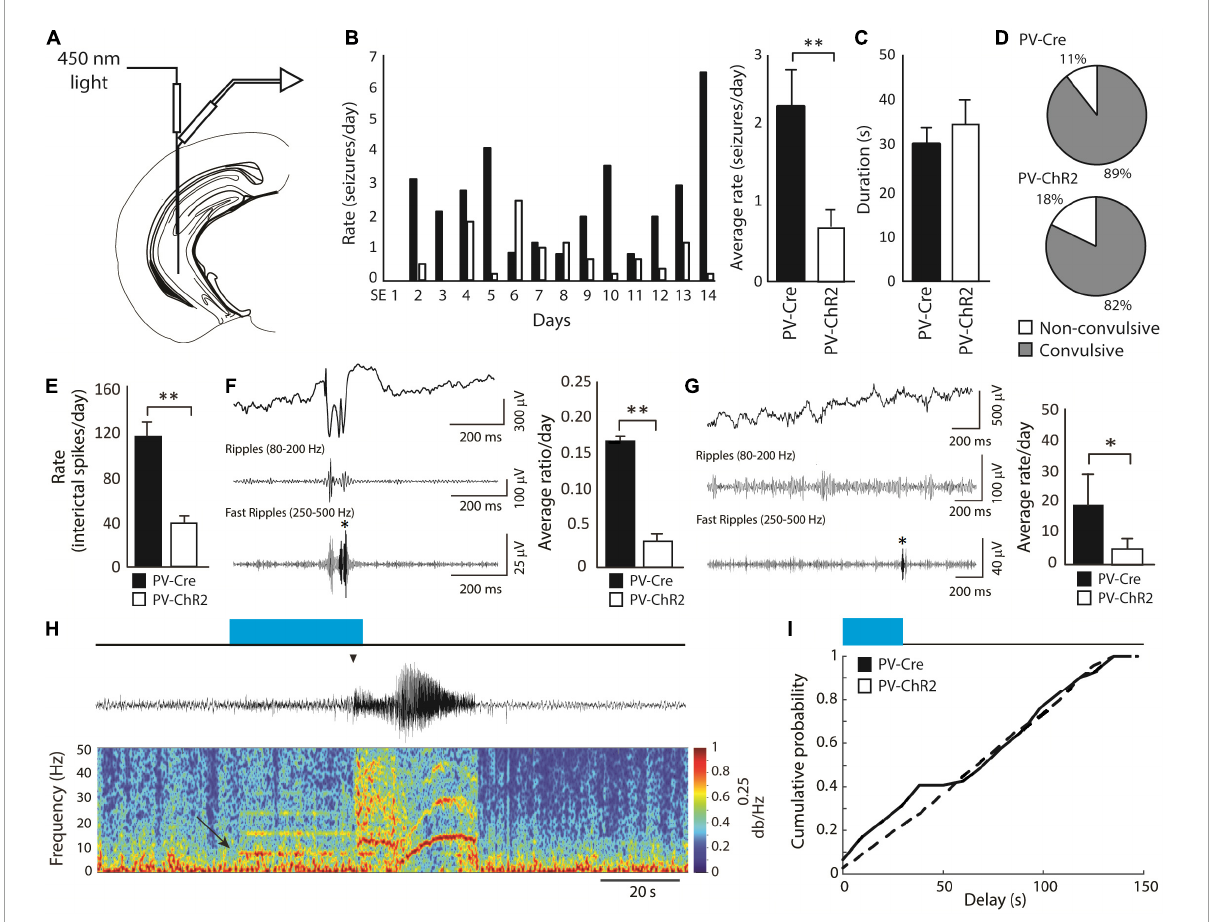
FIGURE5 (A) Schematic diagram showing the location of the optic fiber and electrode in the CA3 region of the hippocampus. The tip of the optic fiber was glued less than 1 mm above the tip of the electrode. Optogenetic stimulation of PV-positive interneurons (8 Hz for 30 s every 2 min) was performed for 14 continuous days, starting 3 days after SE. (B) Average daily rates of spontaneous seizures in PV-ChR2 and PV-Cre animals. PV-ChR2 animals showed significantly less seizures compared to PV-Cre animals ( ∗∗ p < 0.005). (C) Bar graph showing the average duration of seizures in both groups. No significant differences were observed. (D) Proportion of non-convulsive and convulsive seizures in both groups. No significant differences were observed. (E) Bar graph showing rates of interictal spikes in both groups. PV-Cre animals showed significantly higher rates of interictal spikes compared to PV-ChR2 animals ( ∗∗ p < 0.001). (F) Bar graph showing the average ratio of interictal spikes with fast ripples on the total number of interictal spikes for each group. PV-Cre animals showed a higher ratio compared to the PV-ChR2 group ( ∗∗ p < 0.001). A representative example of an interictal spike with a fast ripple is shown on the right. (G) Bar graph showing the average rate of isolated fast ripples in both groups. PV-ChR2 animals showed significantly lower rates of isolated fast ripples compared to PV-Cre animals ( ∗ p < 0.01). (H) Example of a spontaneous seizure that was triggered by optogenetic stimulation of PV-positive interneurons (blue rectangle) in a PV-ChR2 animal. Note that oscillations around 8 Hz in the field (arrow) were triggered by light stimulation and that the seizure